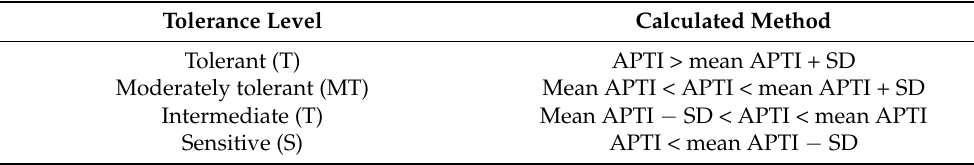
Table 2. The tolerance levels of plants based on the